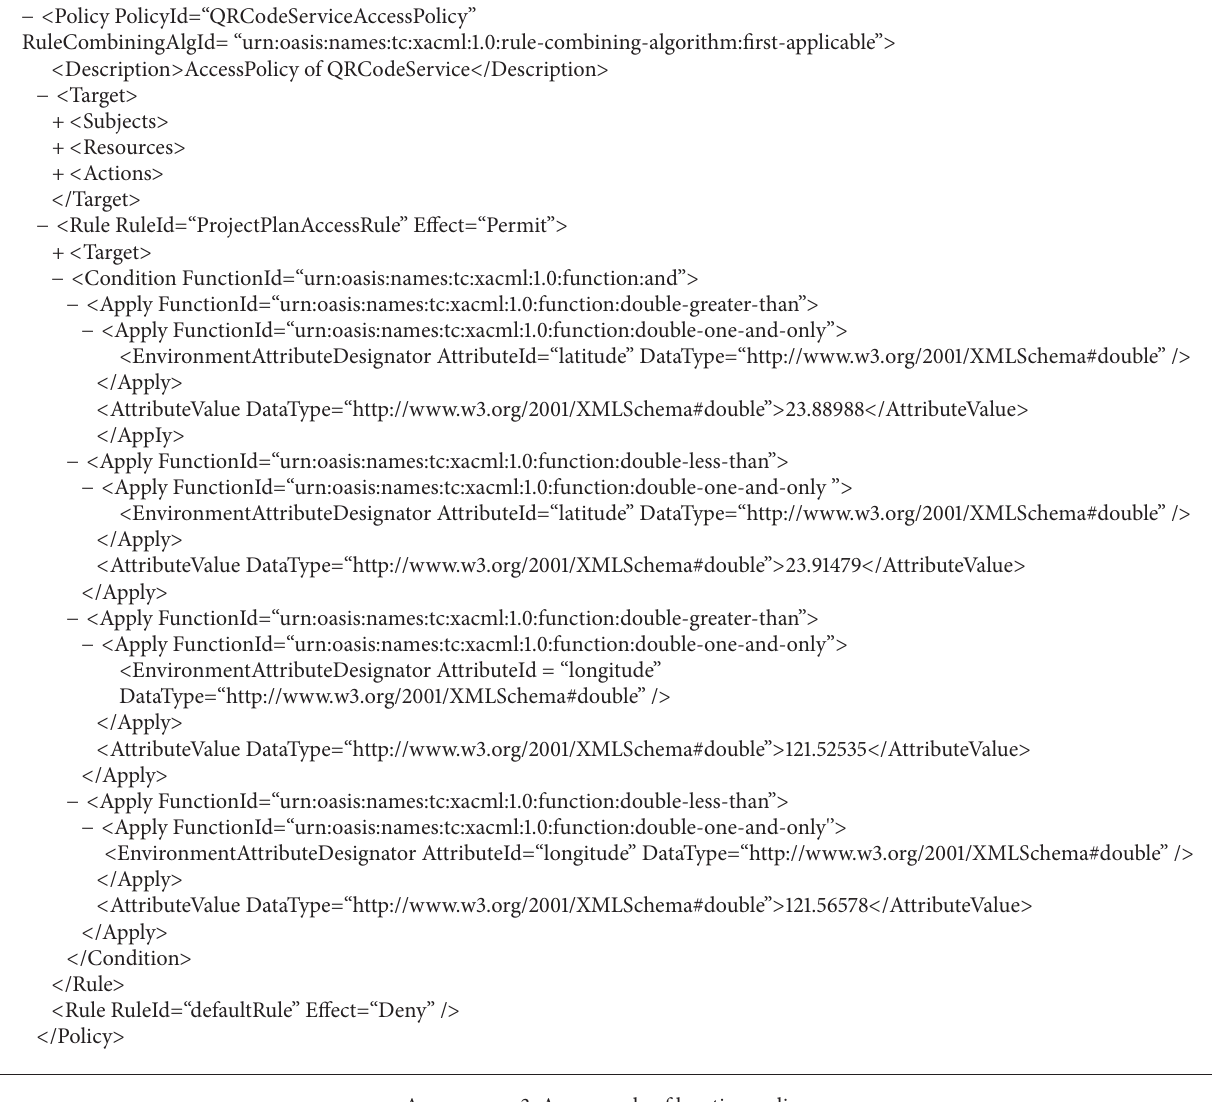
Algorithm 3: An example of location policy.